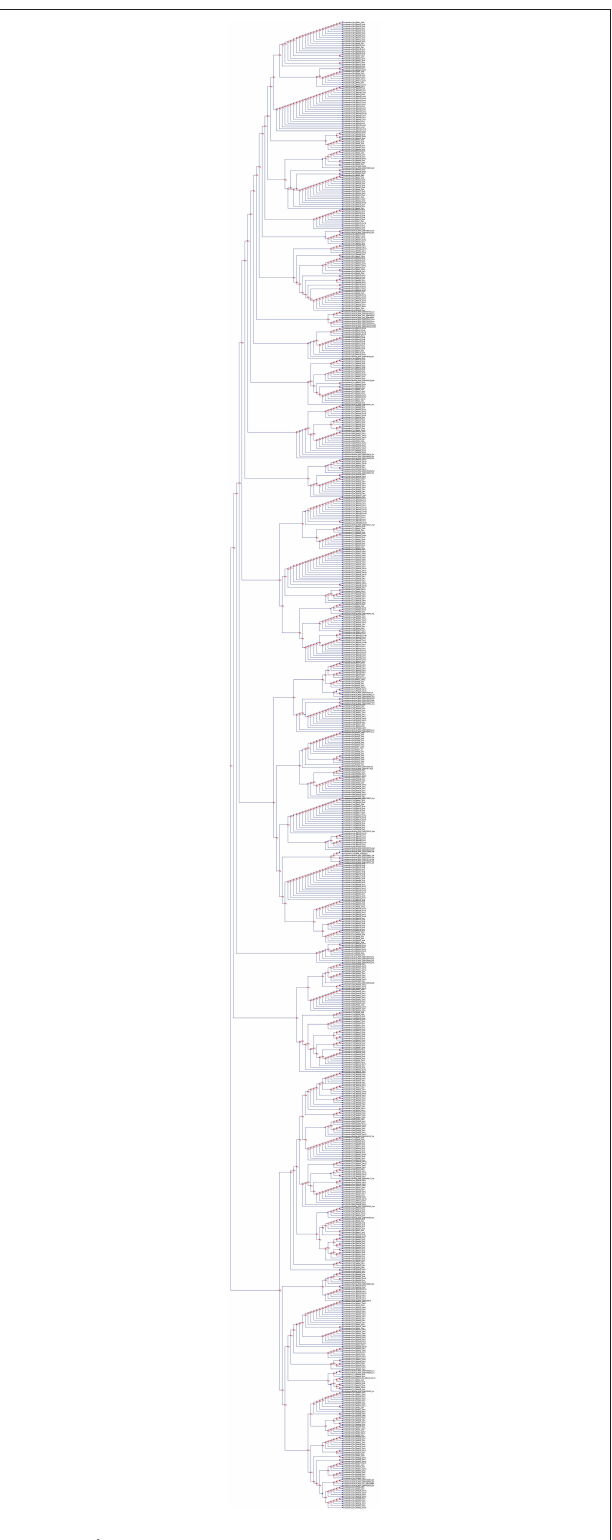
FIGURE 7 | Duplication of O. sativa tRNAs study revealed the presence of 778 duplicated nodes. Duplication study was conducted using Notung 2.6